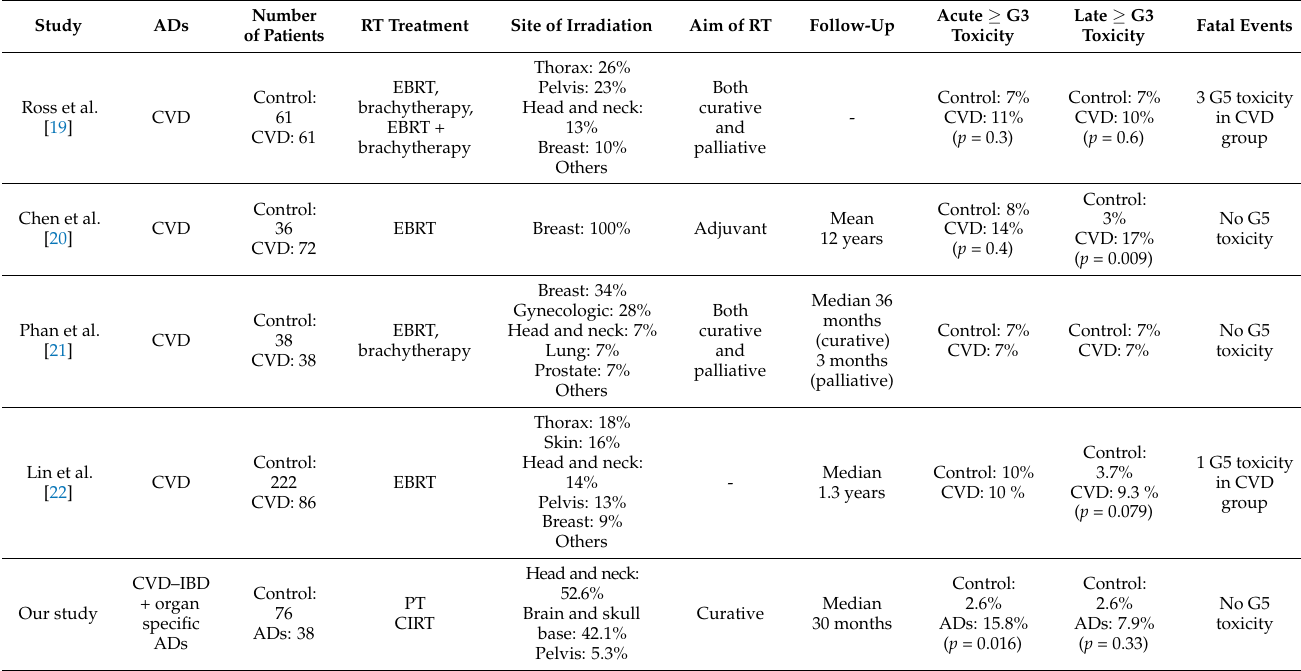
Table 6. Matched control